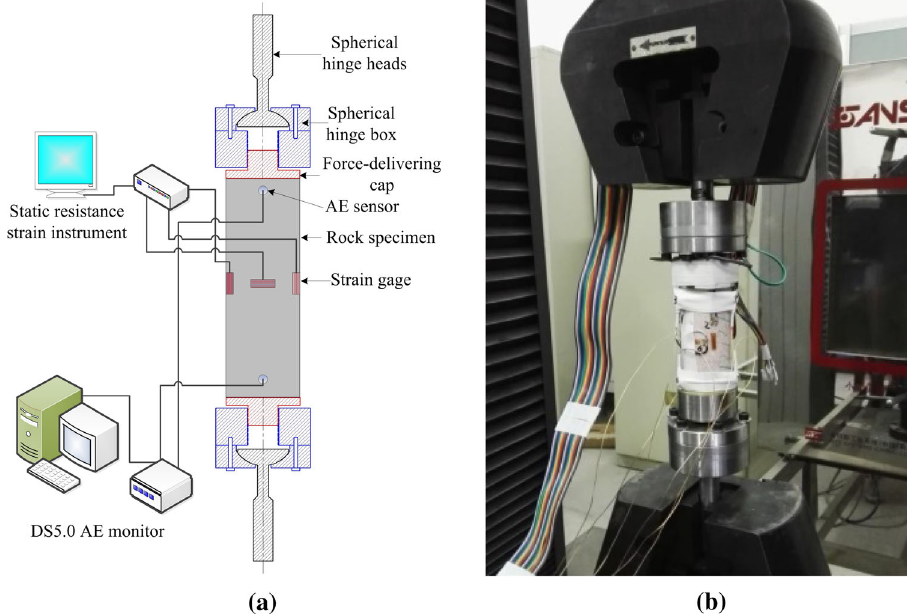
Fig. 1 The sketch and photo of set-up for direct tensile AE test on rock specimens. a Schematic diagram of test device, b photo of the mounted